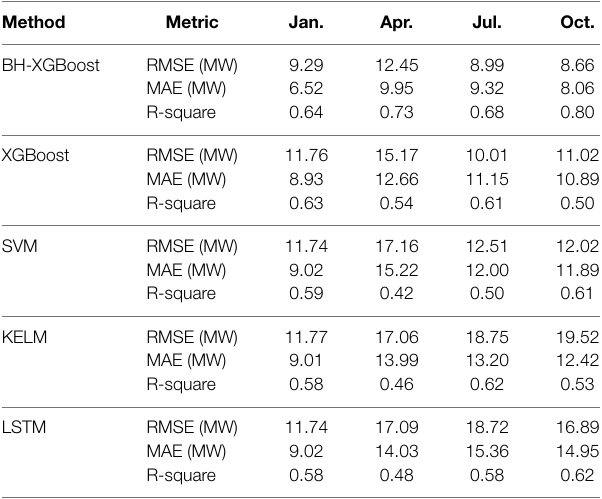
TABLE 2 | XGBoost various parameters. TABLE 3 | The performance of different methods for three